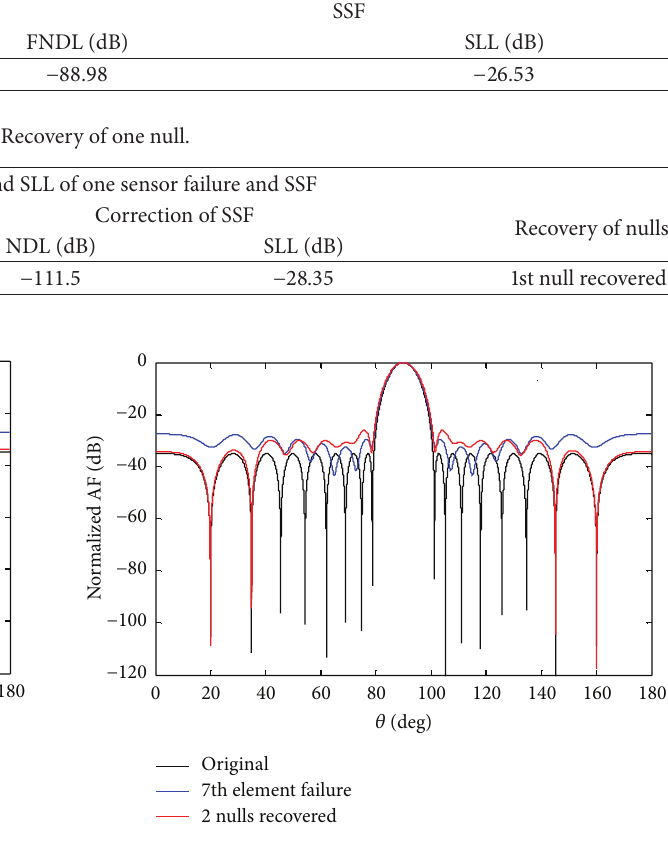
Figure 4: The original radiation pattern, the 𝑤 7 sensor damage, and recovery of one null.